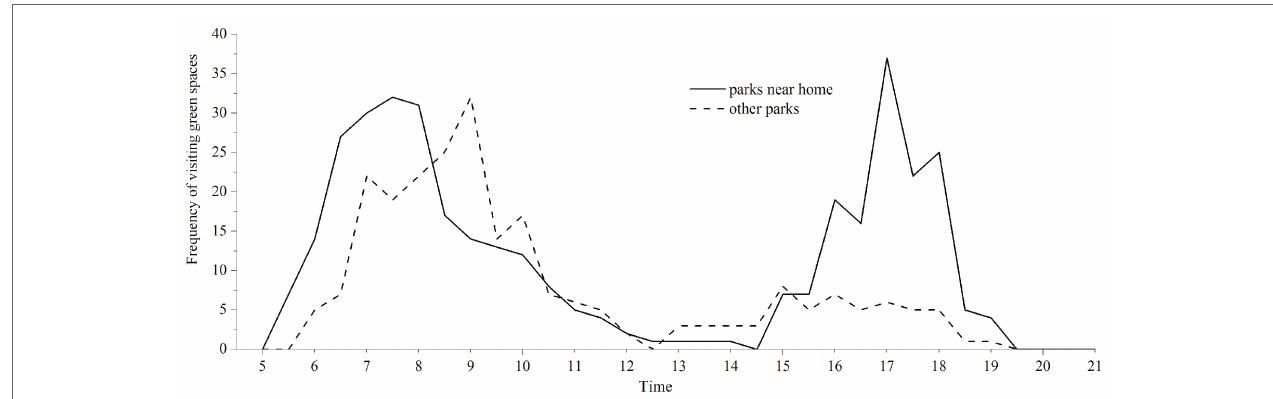
FIGURE 2 | Timing of visits to urban green